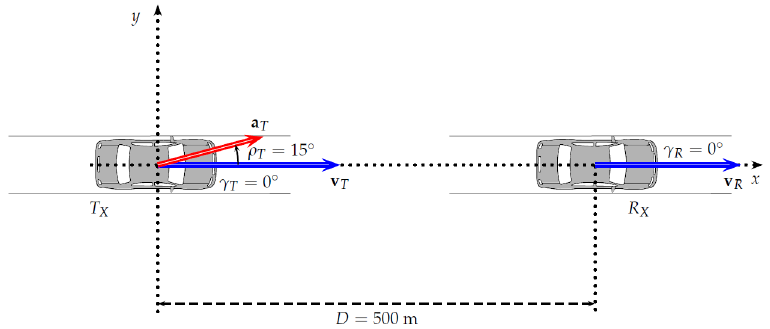
Figure 6. Scenario II: Propagation scenario that recreates an overtaking maneuver, where a vehicle changes its lane before passing another in front.